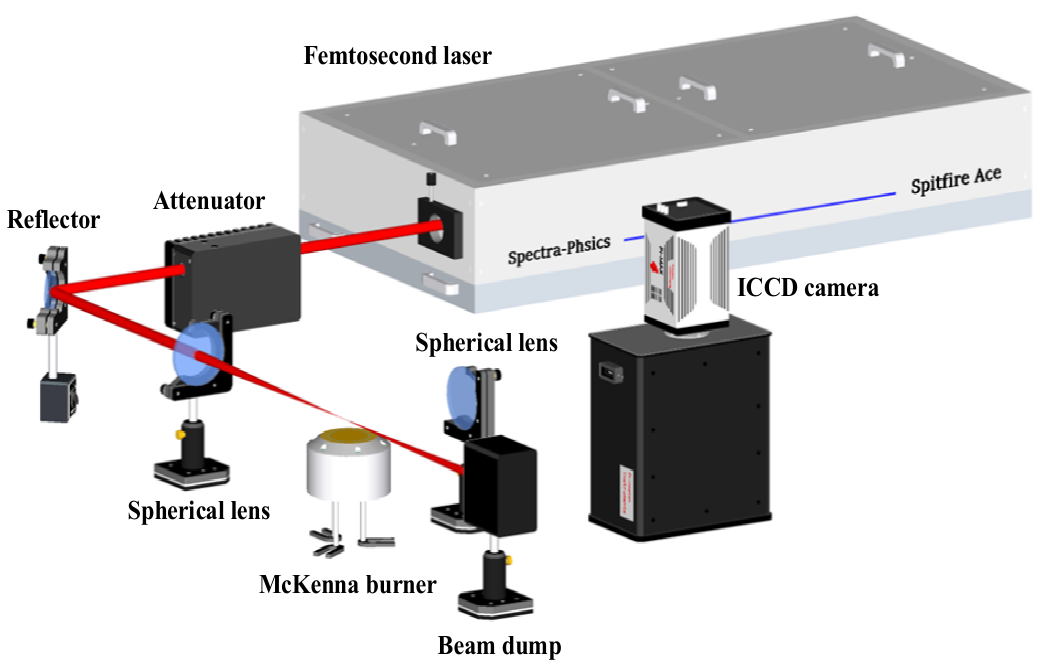
Figure 1. Diagram of experimental setup for equivalence ratio measurement by femtosecond laser-induced filament.